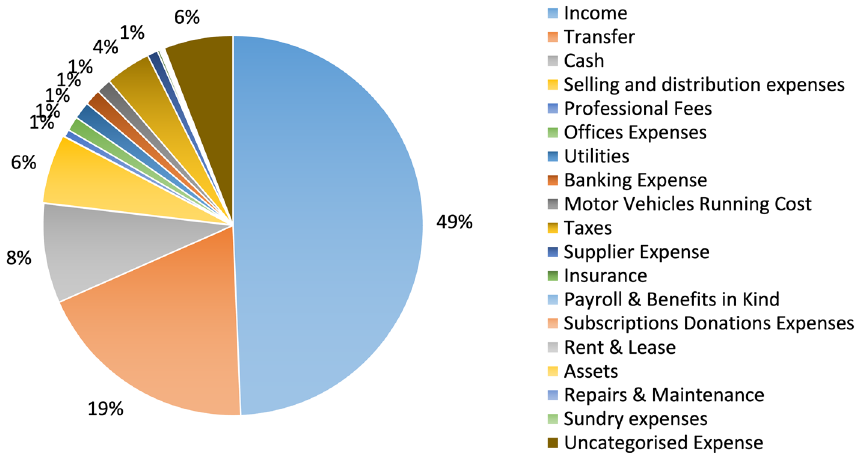
Fig. 7 Rule based step approach categorization